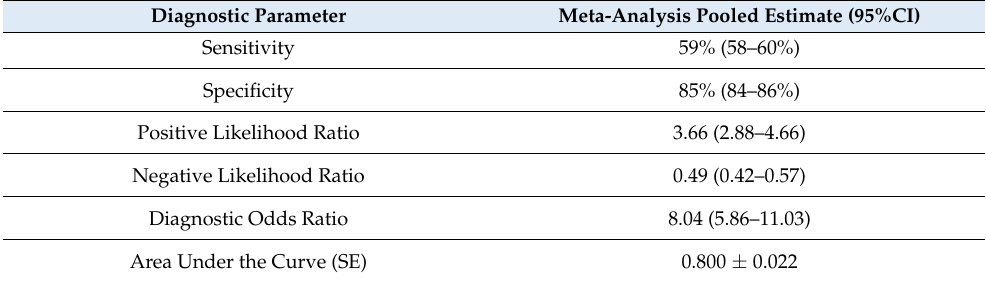
Table 2. Diagnostic accuracy of overall lymph node metastasis detection by ultrasound by radiologists or